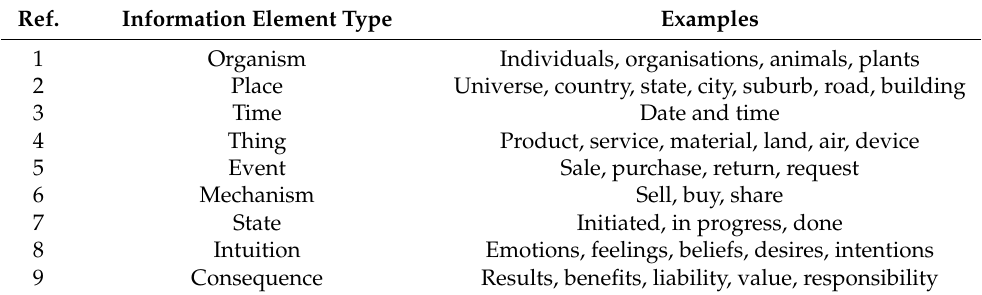
Table 1. Theory of information trilogy—generic information elements (based on [2]).